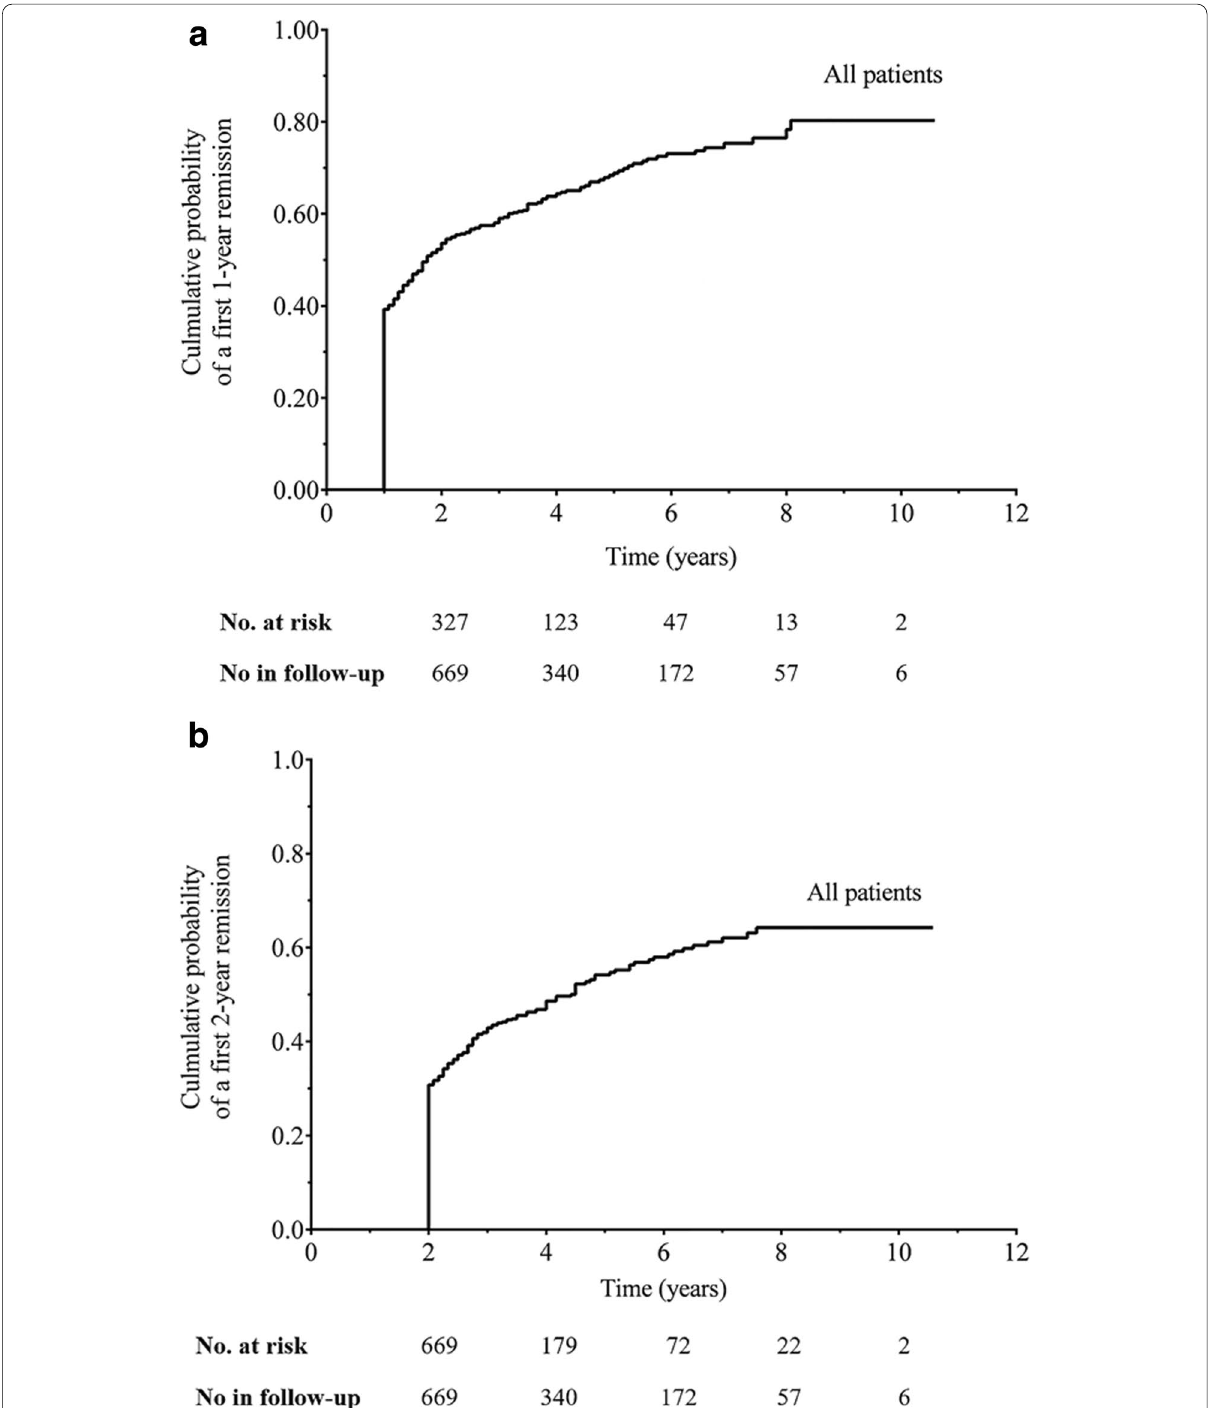
Fig. 1 Kaplan-Meier analyses of time to the first 1-year remission ( a ), and to the first 2-year remission ( b ) in the whole